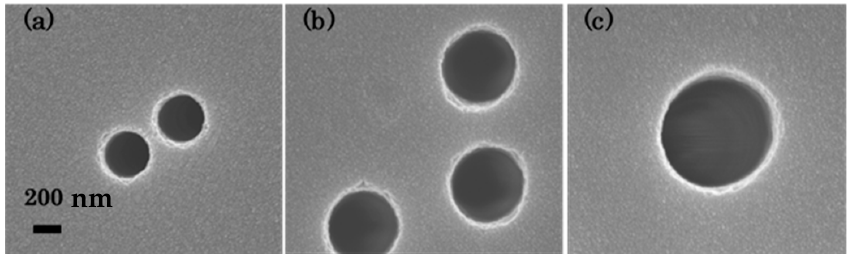
Figure 1. Top-view SEM images of ion-track-etched capillaries in the polyimide films produced using different chemical etching times: ( a ) 10 min, ( b ) 20 min, and ( c ) 40 min.